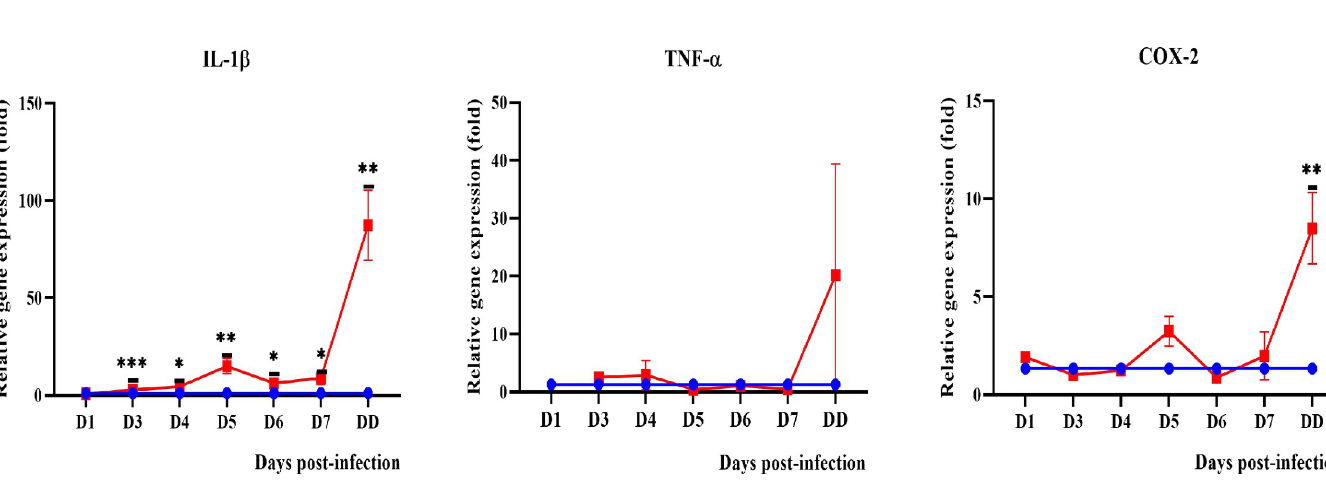
PLOS NeglectedTropical Diseases | https://doi.org/10.1371/journal.pntd.0010409 May 18, 2022 14 /